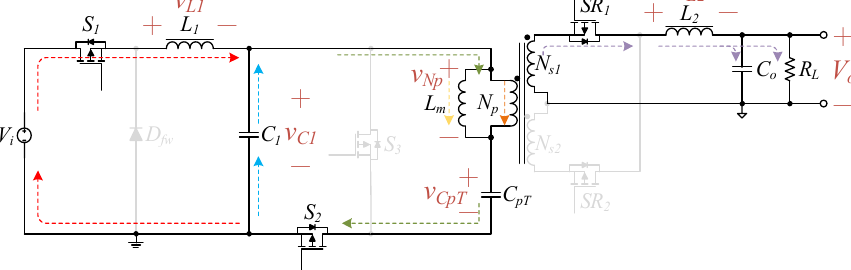
Mode 2 [ DT , 0.5 T ]